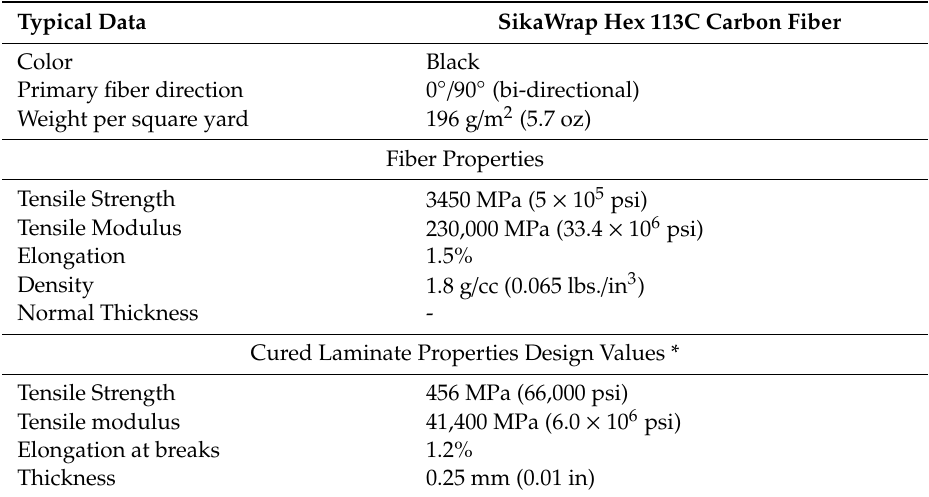
Table 2. SikaWrap Hex 113C carbon fiber fabric properties. Elarbi, 2011 [2].